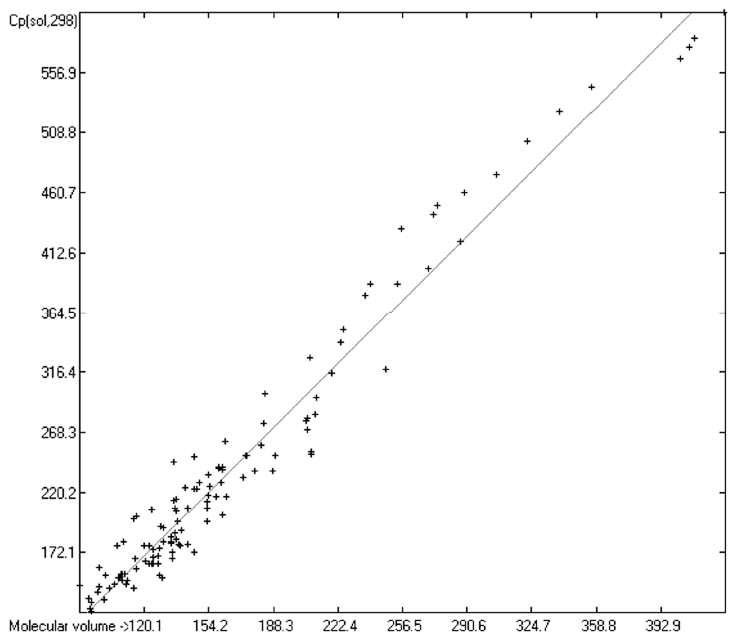
Figure 13. Correlation of molecular volumes with Cp(sol) at 298.15 K of monools and monoacids. (N = 123, R 2 = 0.9613, σ = 21.62 J / mol / K, MAPD = 7.34%, regression line: intercept = − 11.2179, slope = 1.5050, value range from 124.7 to 604.8 J / mol / K).